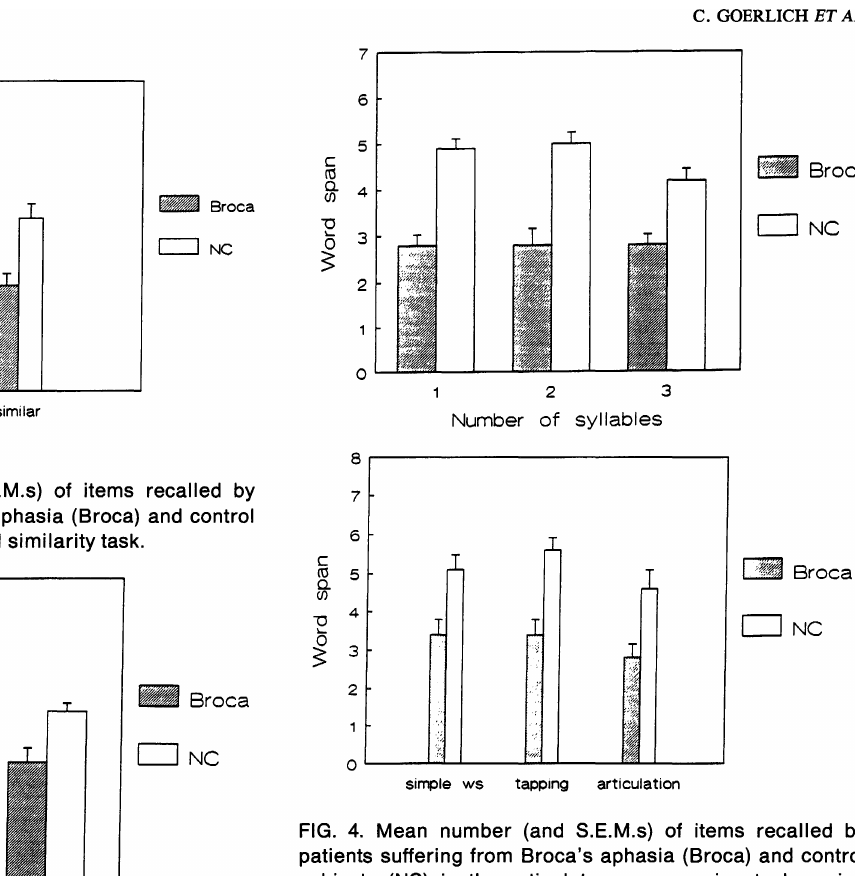
FIG. 4. Mean number (and S.E.M.s) of items recalled by patients suffering from Broca's aphasia (Broca) and control subjects (NC) in the articulatory suppression tasks using digits (top) or words (bottom),